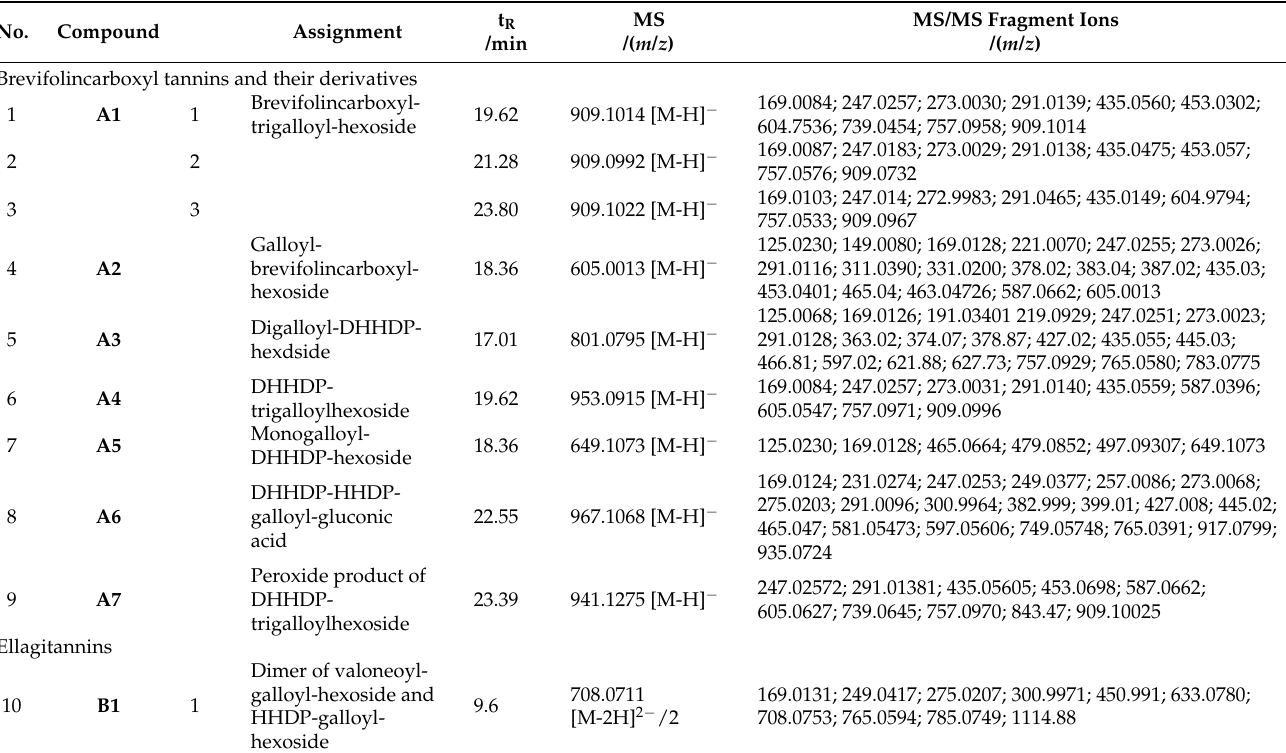
Figure 1. The total ion chromatogram of seeds water extract of Cornus officinalis Sieb. et Zucc. in the negative ESI model (the new type tannins are red dotted). Table 1. Retention times (t R ) and mass fragmentation data of compounds present in the seed water extract of Cornus officinalis Sieb. et Zucc.